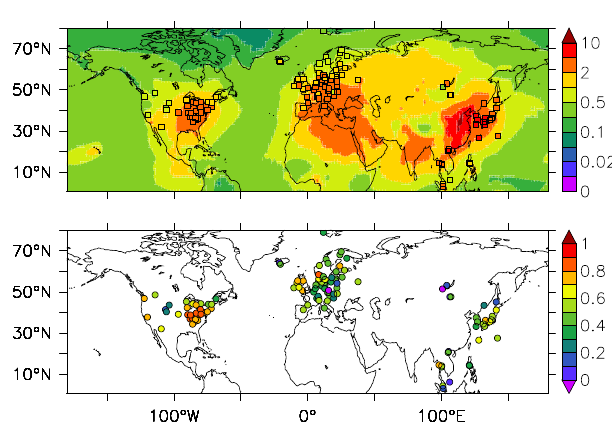
Fig. 5. UPPER: simulated mean concentrations of SO 2 − µgm − 3 ) for the year 2005–2008, with observations from CAST- NET, EMEP and EANET (averaged over the same period) over- plotted. LOWER: temporal correlation of observations from CAST- NET, EMEP and EANET and model results for SO 2 −